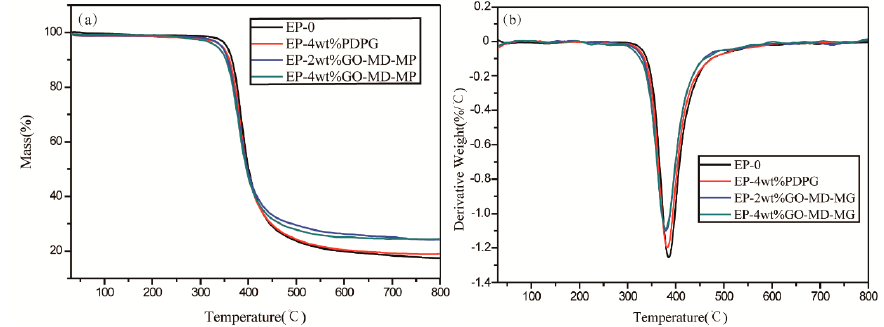
Figure 10. The TGA ( a ) and DTG ( b ) curves of the different cured EP composites.